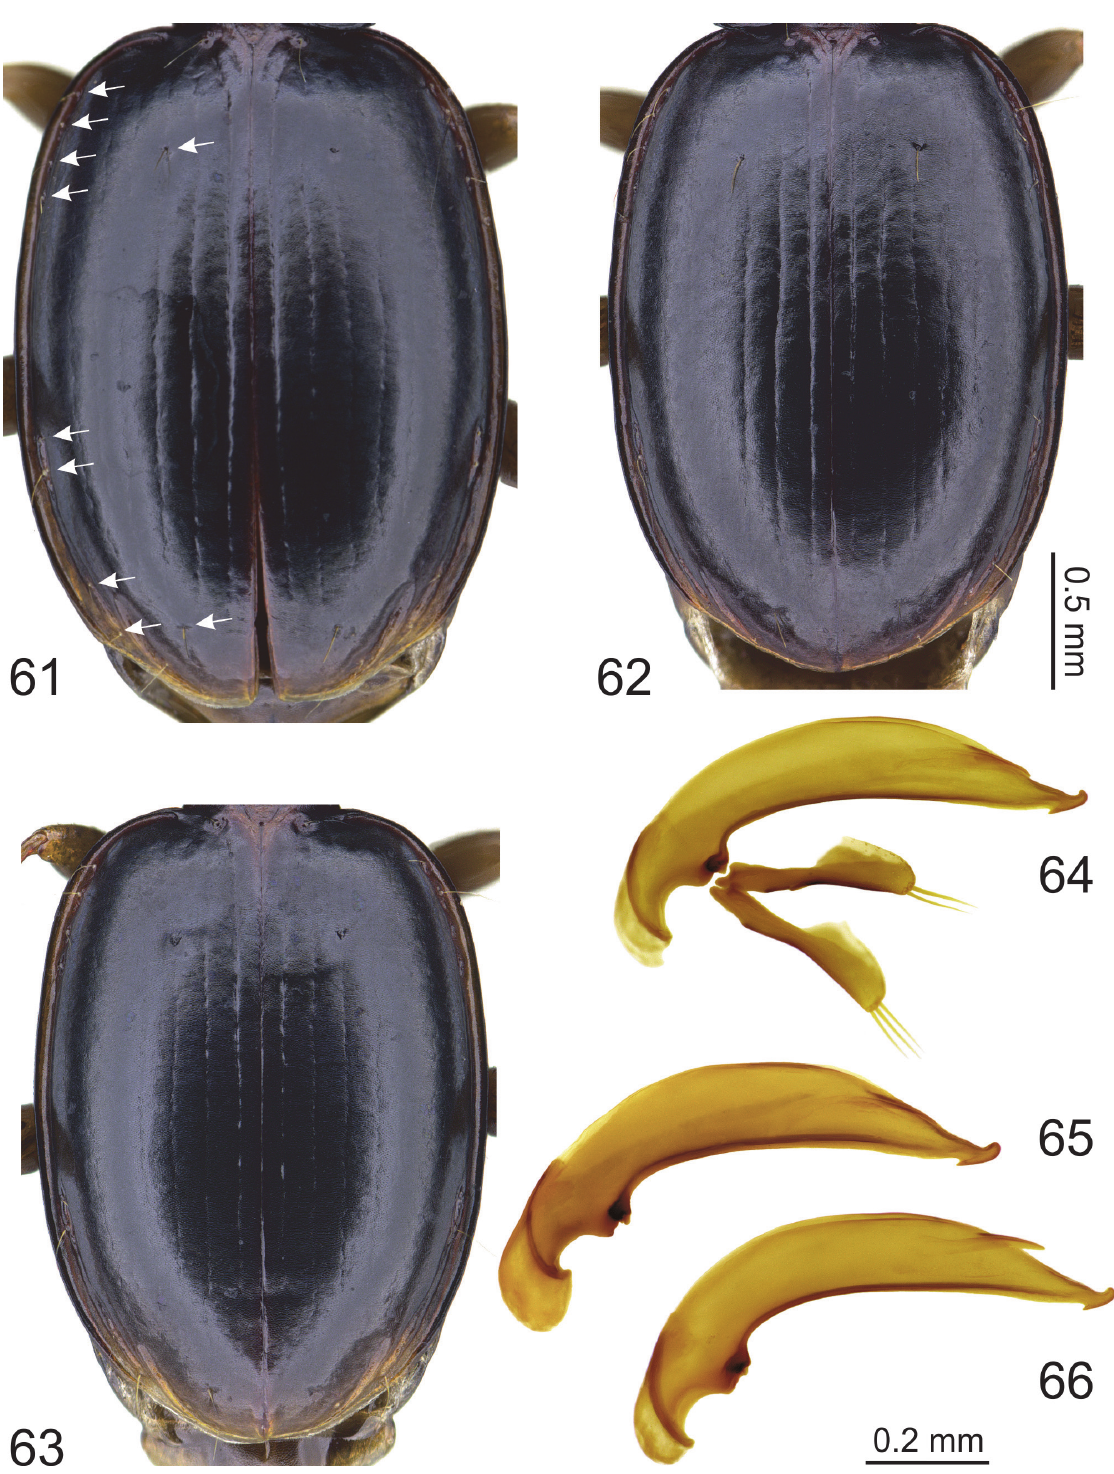
Figs 61–66. Trechus oromiensis Magrini, Quéinnec & Vigna Taglianti, 2012, elytra (61–63) and aedeagal median lobe (64–66). 61, 64 . Specimen from Mt Chillalo (the arrows point to the insertions of the discal seta, preapical seta, and setae of the umbilical series). 62, 65 . Specimen from Mt Enkuolo. 63, 66 . Specimen from Goba, Bale Mts, locus typicus of T.